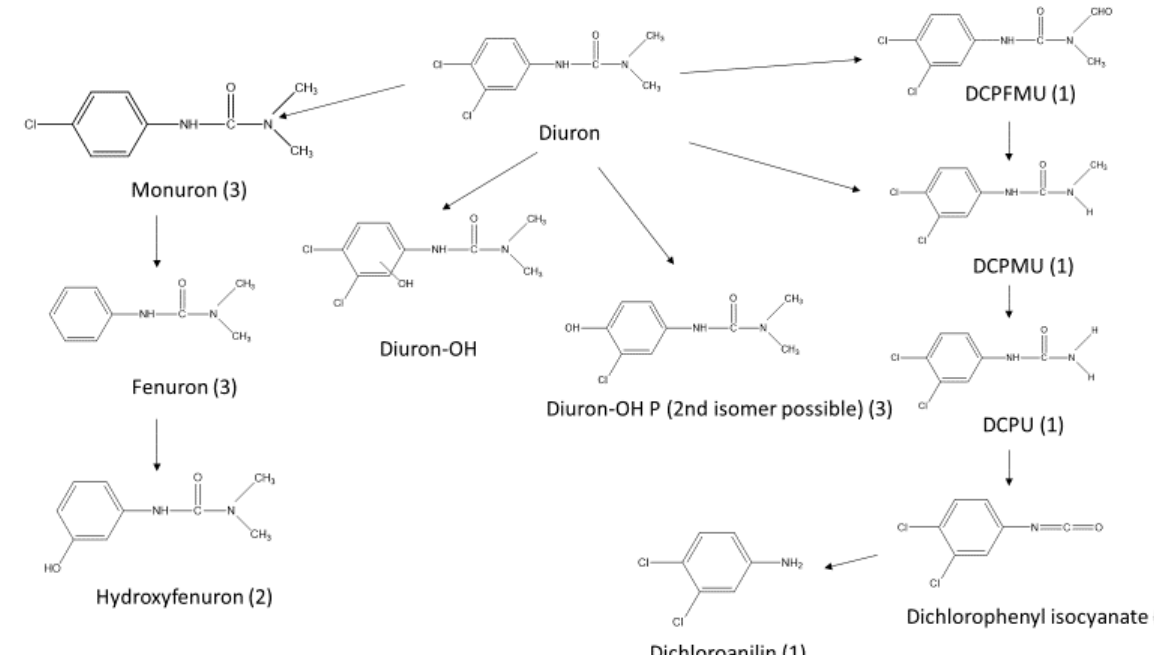
Figure 8. Possible transformation of diuron. (1) Substances were observed during the experiments on paints and confirmed by analysis of reference standards; (2) substances were indicated by the mass signals observed in samples from the photolysis experiments of substances in water; and (3) substances were detected in both experiments.